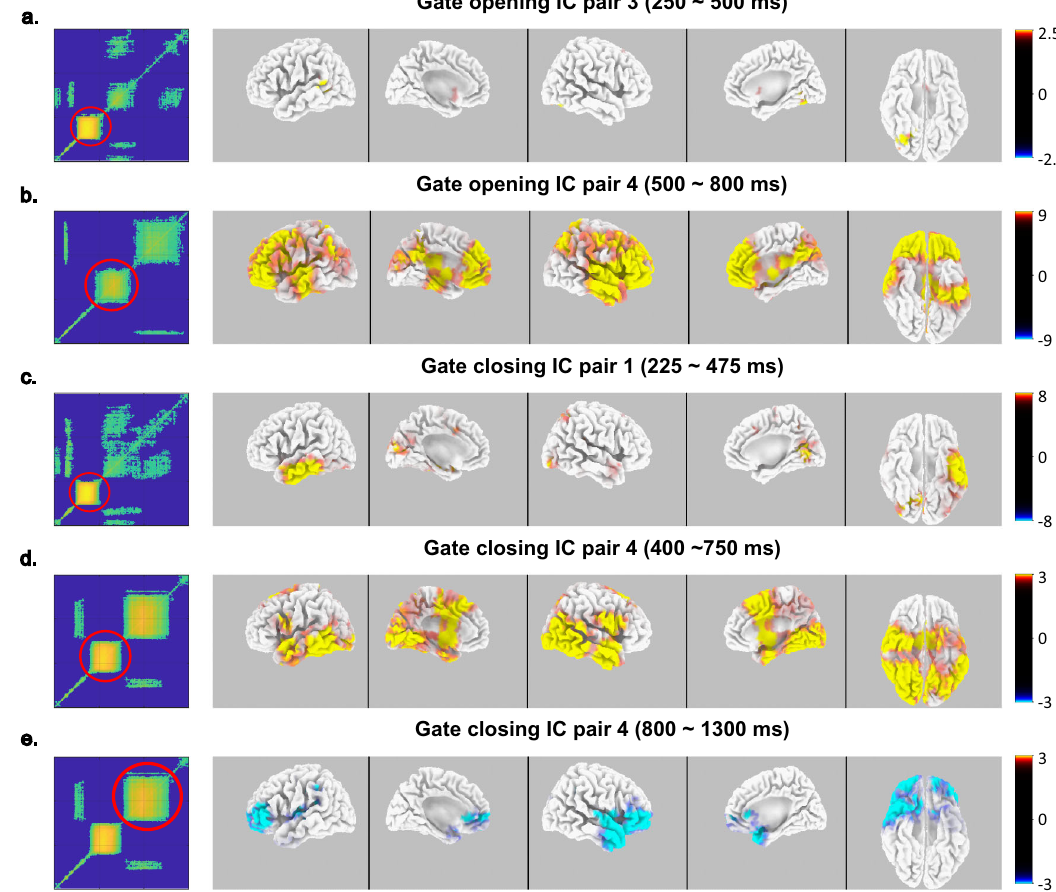
Fig. 4 Source localization of working memory gating dynamics. The title indicates the independent component (IC) pair and the time window selected for sLORETA analysis for each plot ( a – e ). The temporal generalization result of this IC pair is presented on the left in each plot from ( a ) to ( e ) with a red circle marking the cluster utilized for sLORETA. The source of the working memory gating dynamics is illustrated from fi ve orientations (from left to right: lateral- left, medial-left, lateral-right, medial-right, and bottom) presented on the right in each plot from ( a ) to ( e ). The color bar represents the critical t -values using N = 33 samples. The color key on the right of each plot from ( a ) to ( e ) denotes t